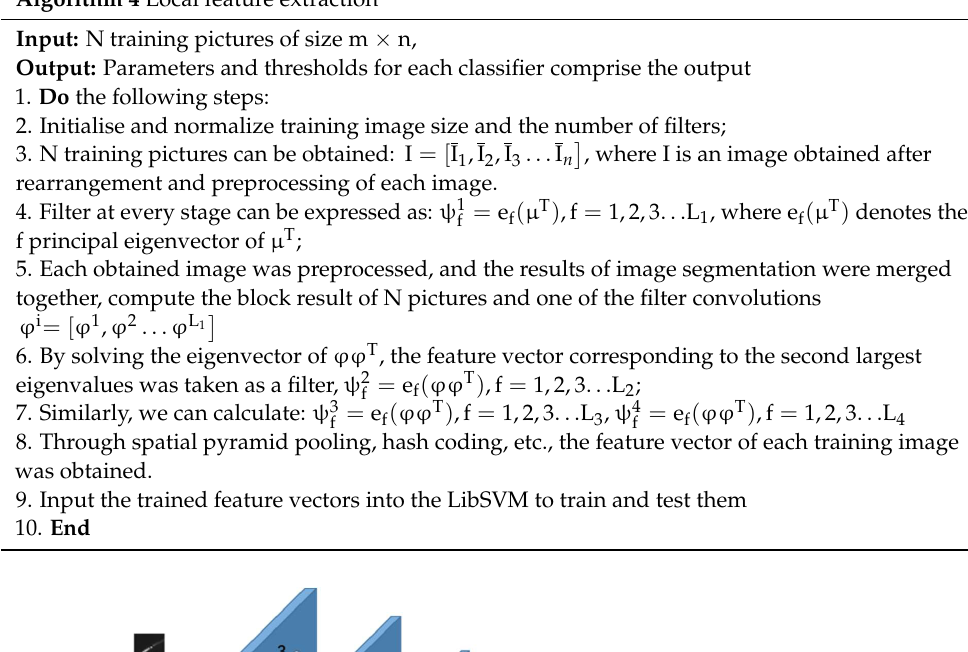
Algorithm 4 Local feature extraction